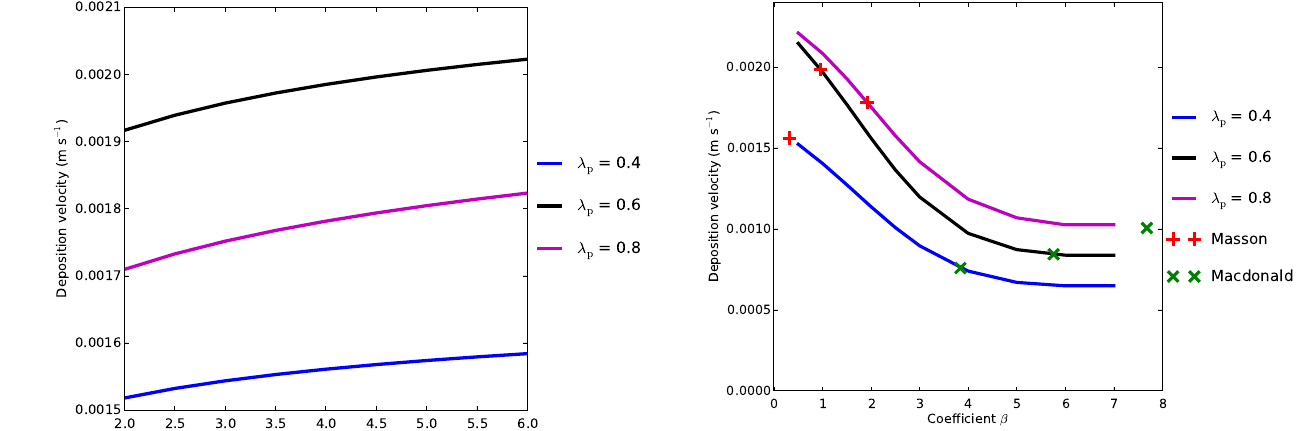
Figure 15. Dry deposition velocity as a function of α and building density.